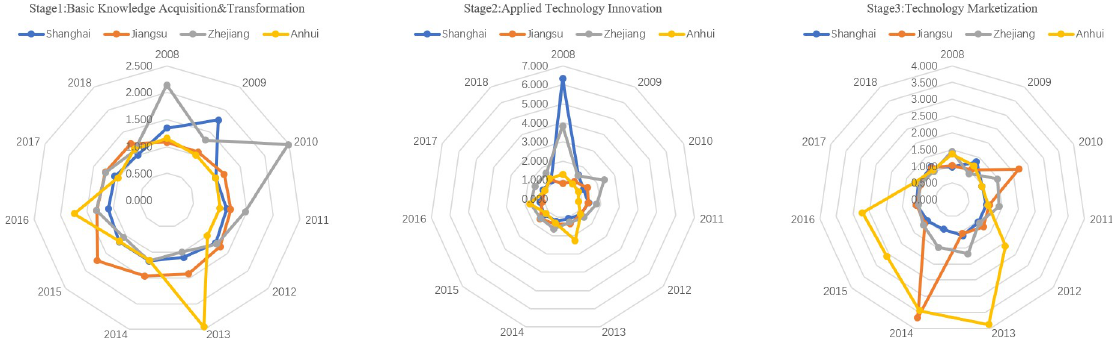
Fig 3. Efficiency of university basic knowledge transformation stage in Yangtze River Economic Belt.